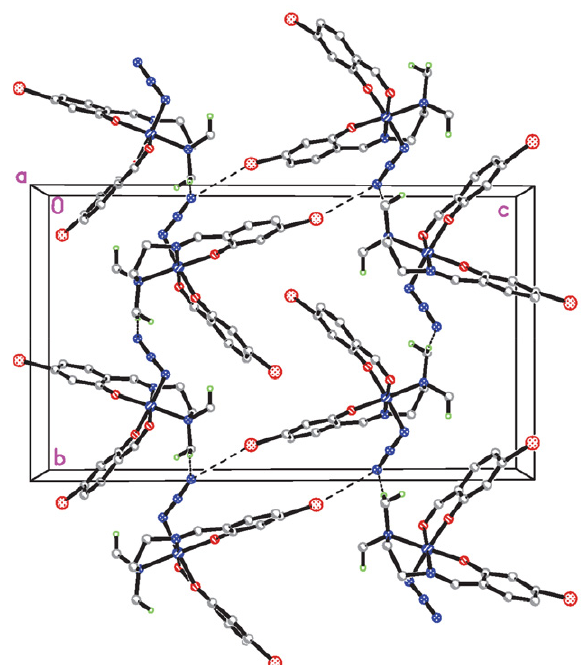
Fig. 5. Molecular structure of complex 3 .